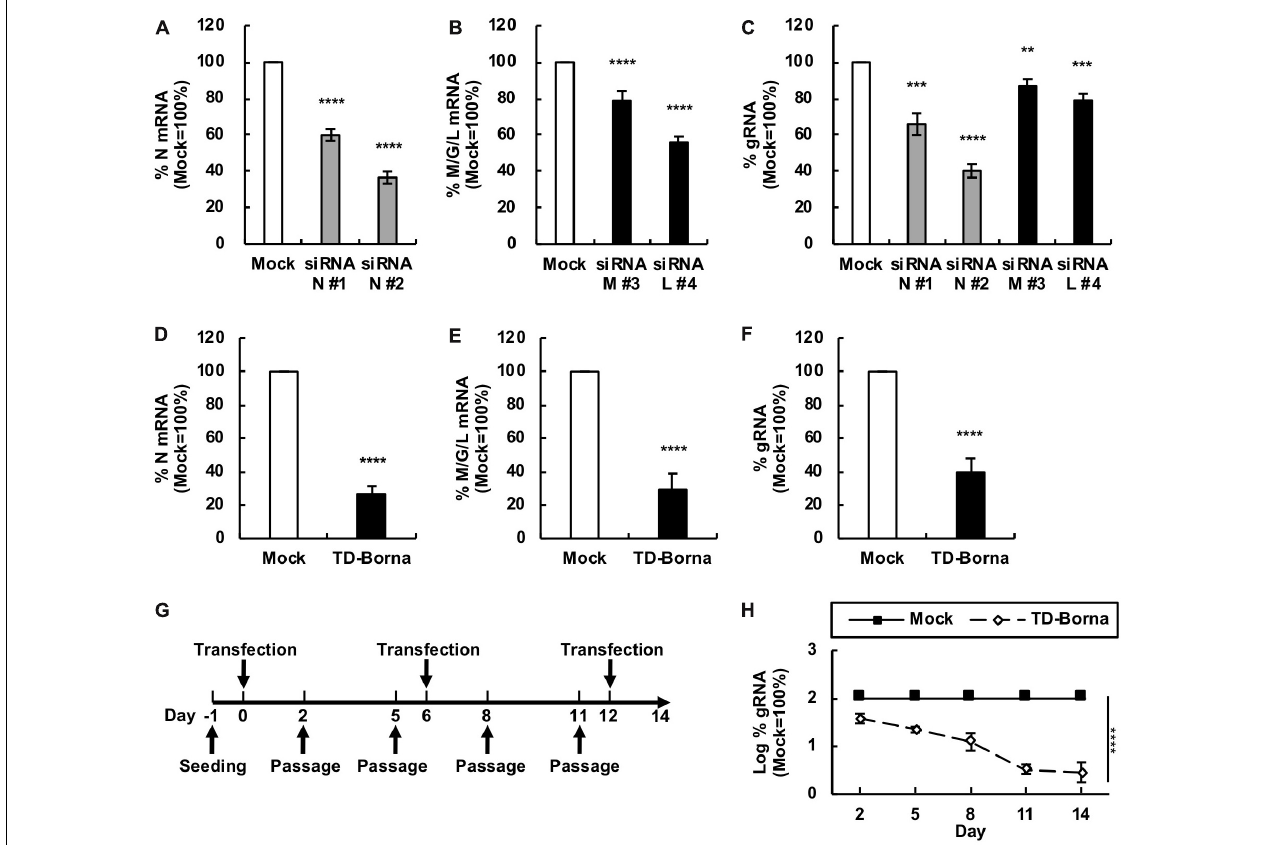
FIGURE 2 | Reduction in the BoDV-1 load by siRNAs targeting N and M/G/L mRNAs. (A,B) Effects of siRNAs targeting BoDV-1 mRNAs on BoDV-1 mRNA amounts. 293T/BoDV cells were treated with the indicated siRNA for 2 days. The amounts of N (A) and M/G/L (B) mRNAs in 293T/BoDV cells were determined by RT-qPCR analyses. (C) Effects of siRNAs targeting BoDV-1 mRNAs on BoDV-1 replication. The amount of BoDV-1 gRNA in 293T/BoDV cells was determined by RT-qPCR analyses. (D,E) Effects of the siRNA cocktail (TD-Borna) targeting BoDV-1 N and M/G/L mRNAs on BoDV-1 mRNAs. 293T/BoDV cells were treated with TD-Borna for 2 days. The amounts of N (D) and M/G/L (E) mRNAs in 293T/BoDV cells were determined by RT-qPCR analyses. (F) Effects of TD-Borna on BoDV-1 replication. The amount of BoDV-1 gRNA in 293T/BoDV cells was determined by RT-qPCR analyses. (G) Protocol for long-term TD-Borna treatment in 293T/BoDV cells. 293T/BoDV cells were seeded in 12-well plates (2 × 10 5 cells/well) on Day –1. TD-Borna was transfected on Days 0, 6, and 12. The cells were passaged into new 12-well plates (2 × 10 5 cells/well) every 3 days. (H) Effects of long-term TD-Borna treatment on BoDV-1 replication. The amount of BoDV-1 gRNA in 293T/BoDV cells was determined by RT-qPCR analyses. Mock, the scrambled siRNA-treated control. Values are expressed as the mean ± SE of three independent experiments. ∗∗ P < 0.01, ∗∗∗ P < 0.005, and ∗∗∗∗ P < 0.001 (vs. mock).